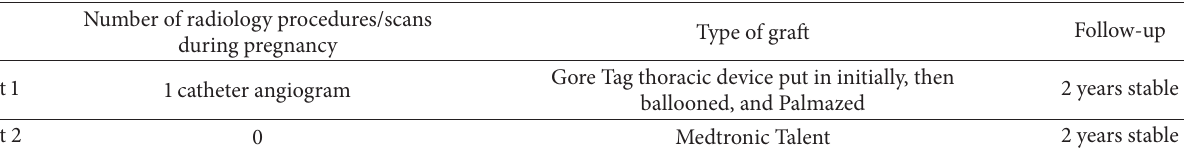
Table 1: Summary of the details of the procedures and outcomes.